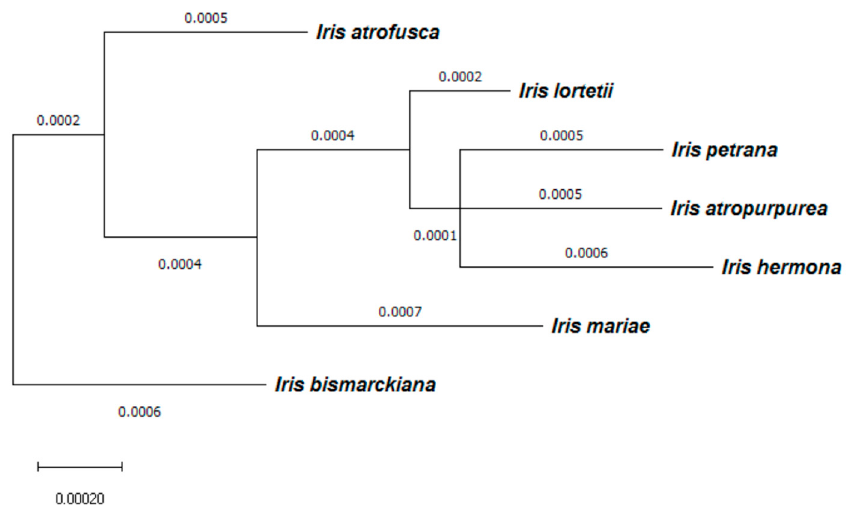
Figure 7. Phylogenetic tree of the 8 Israeli Iris species. Phylogeny based on data retrieved from the OneTwoTree web server [39]. Scale: number of SNPs in 1000 sequence bases.